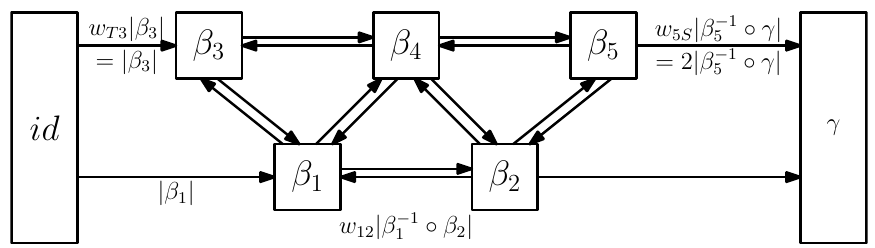
Figure 18 . The flow network corresponding to a tensor network. Going from a permutation β to β 0 we have a weight depending on β − 1 ◦ β 0